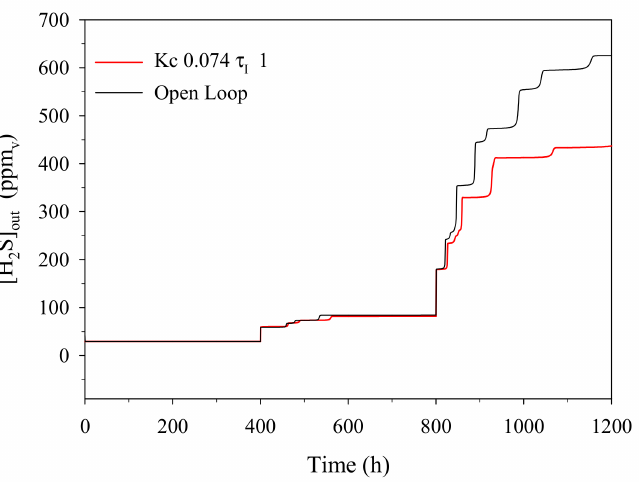
Figure 6. AFR-CL strategy results. H 2 S outlet concentration evolution (process variable) during O 2 control facing inlet H 2 S concentration changes using a PI controller showing stable